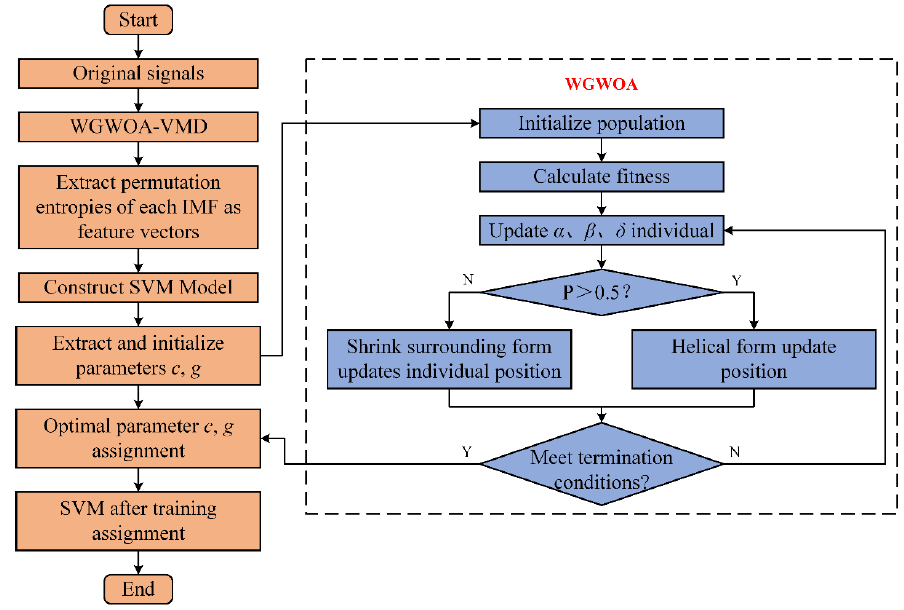
Figure 2. Flowchart of fault diagnosis based on the optimized